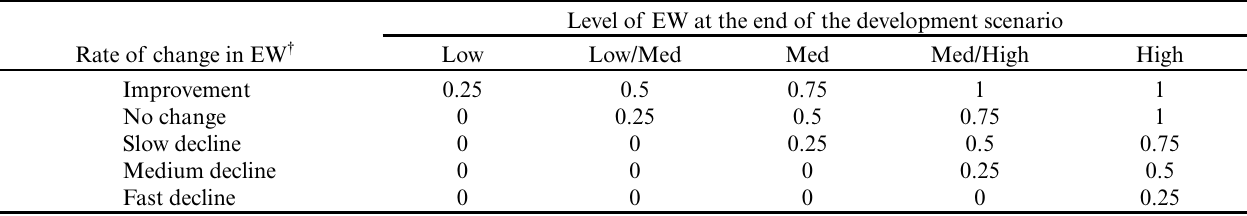
Table 3 . Natural capacity (NC) score based on combination of environmental well-being (EW) level and direction and rate of change in EW (“Med“ = medium).